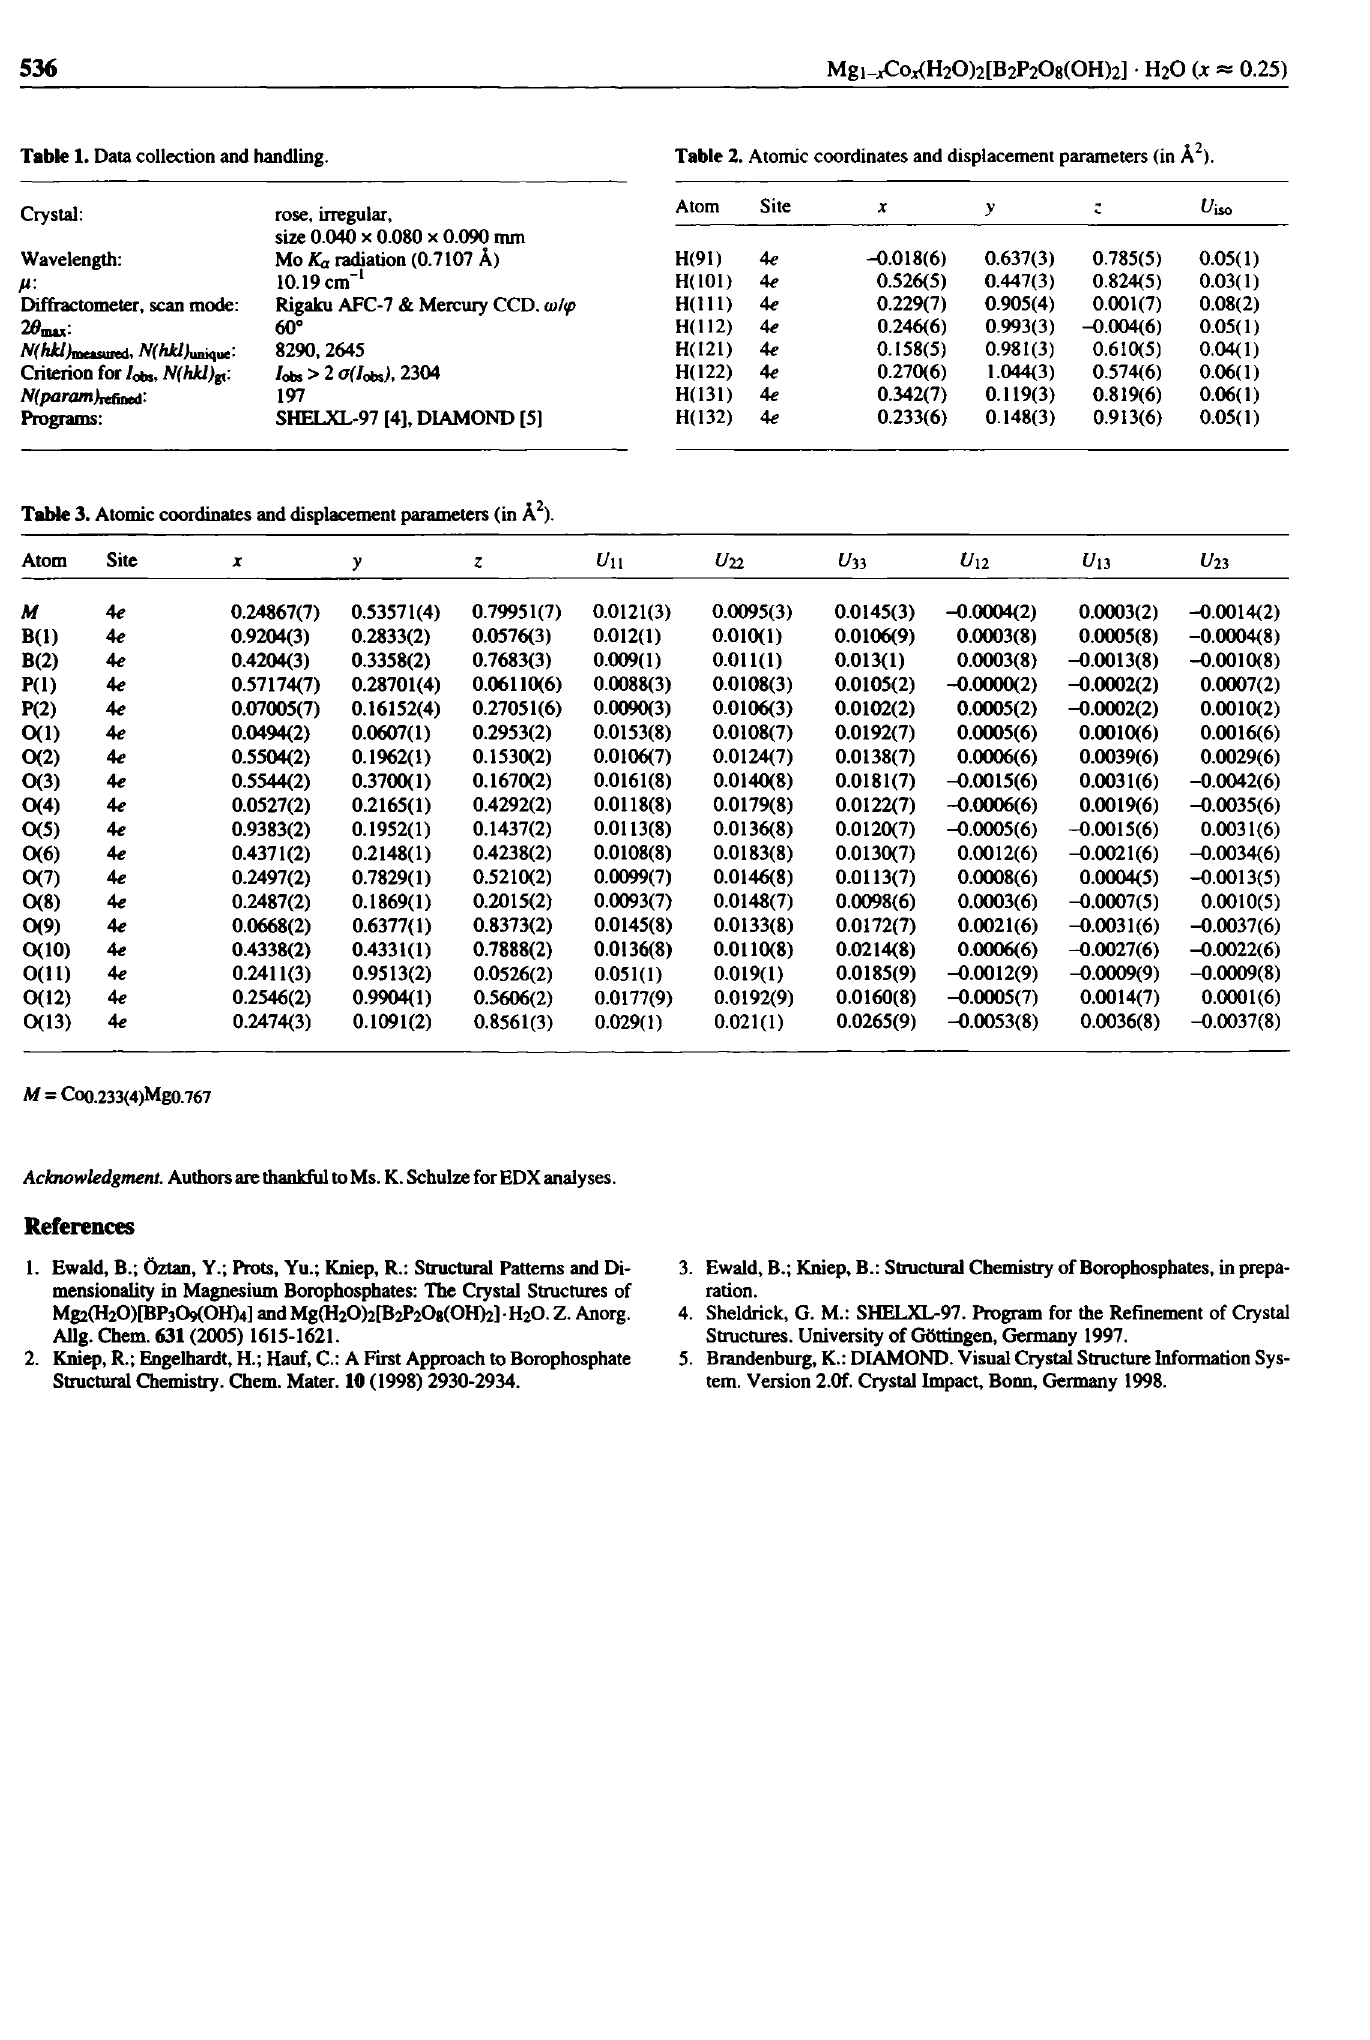
Table 1. Data collection and handling. Table 2. Atomic coordinates and displacement parameters (in A 2 ).